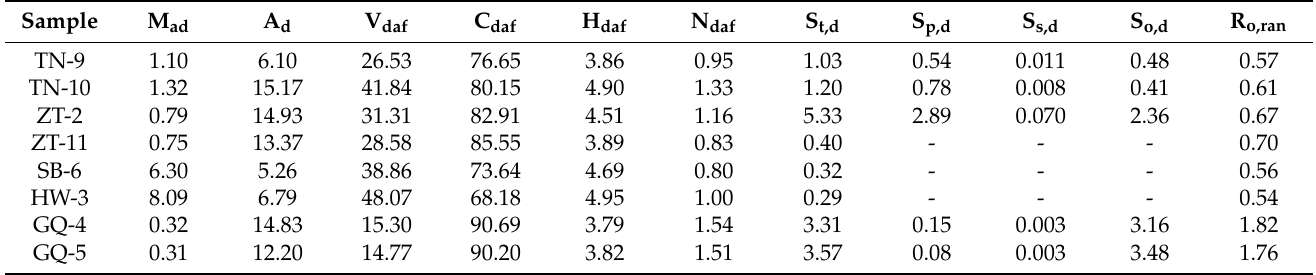
Table 3. Proximate and ultimate analyses (%), forms of sulfur (%) and vitrinite random reflectance (%) of the coal